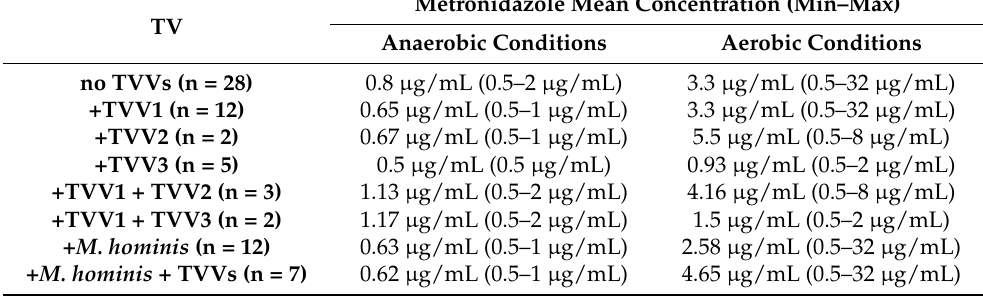
Table 3. Metronidazole susceptibility (mean and range) for TV harbouring different TVVs and TVV combinations, as well as TV harbouring M. hominis (+ M. hominis ) and TV where TVVs and M. hominis were present (+TVV + M. hominis ).